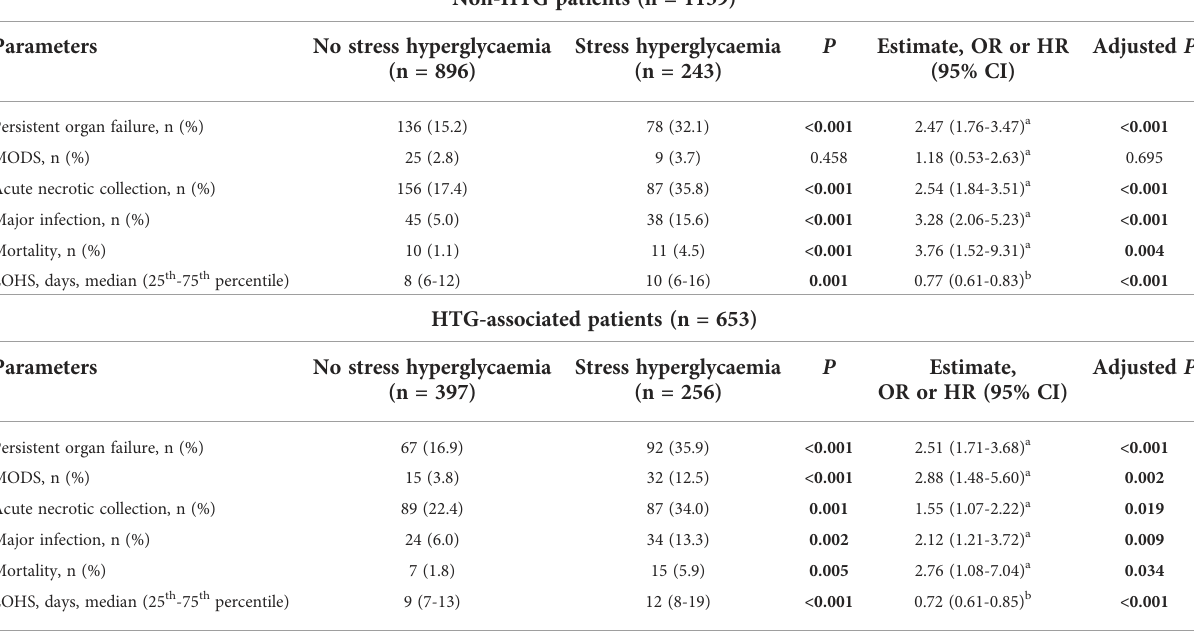
TABLE 3 Clinical outcomes of patients strati fi ed by stress hyperglycaemia in non-HTG and HTG groups on admission.